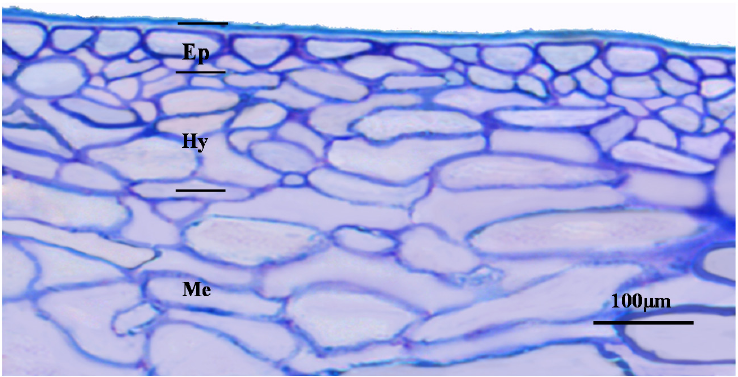
Figure 2. Traverse section of grape berry skin at maturity: epidermis and cuticle (Ep), hypodermis (Hy), mesocarp (Me).